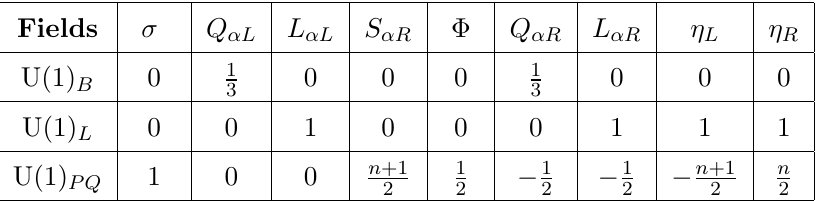
Table 1 . Field transformations under the global symmetries, where n is an